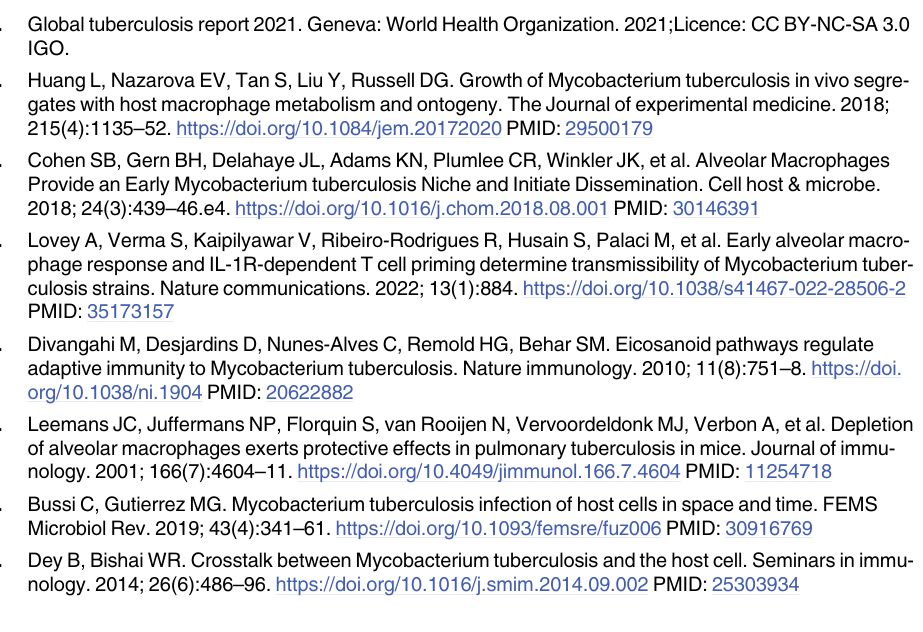
S1 Table. Reagents and Antibodies.